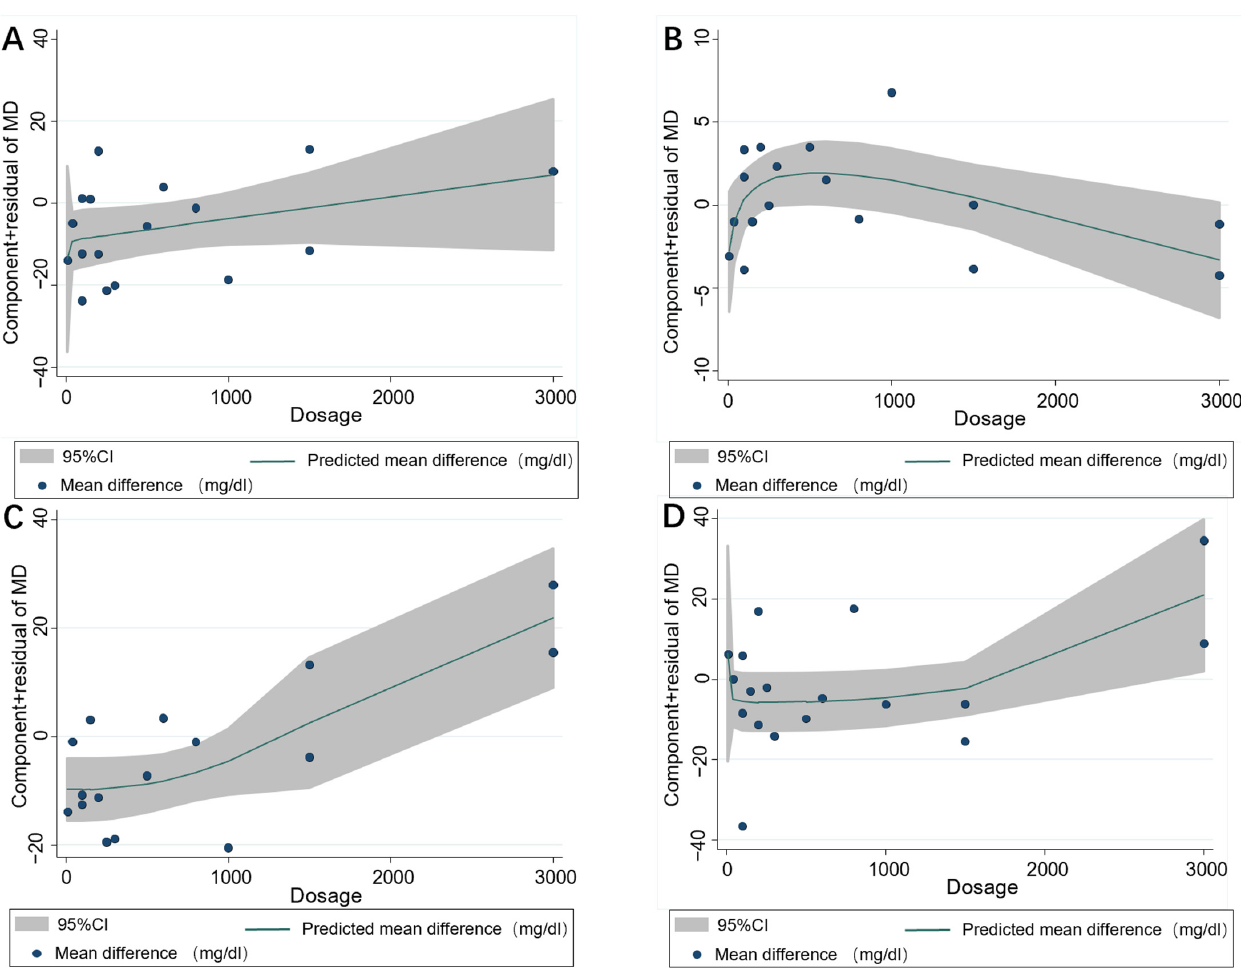
Figure 3. Nonlinear dose–response relations between resveratrol dosage (mg) and unstandardized mean difference (mg/dL) in ( A ) TC, ( B ) HDL-C, ( C ) LDL-C and ( D ) TG. The 95% CI is demonstrated in the shaded regions. TC = Total cholesterol; LDL-C = Low-density lipoprotein cholesterol; HDL-C = High-density lipoprotein cholesterol; TG = Triglyceride.